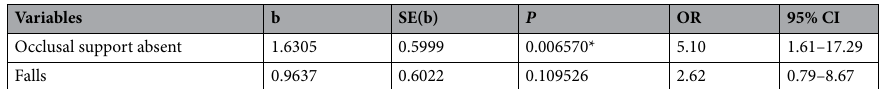
Table 2. Multiple Logistic Analysis of Odds Ratio of mandibular fractures (angle and condyle fractures). * Means significant statistical